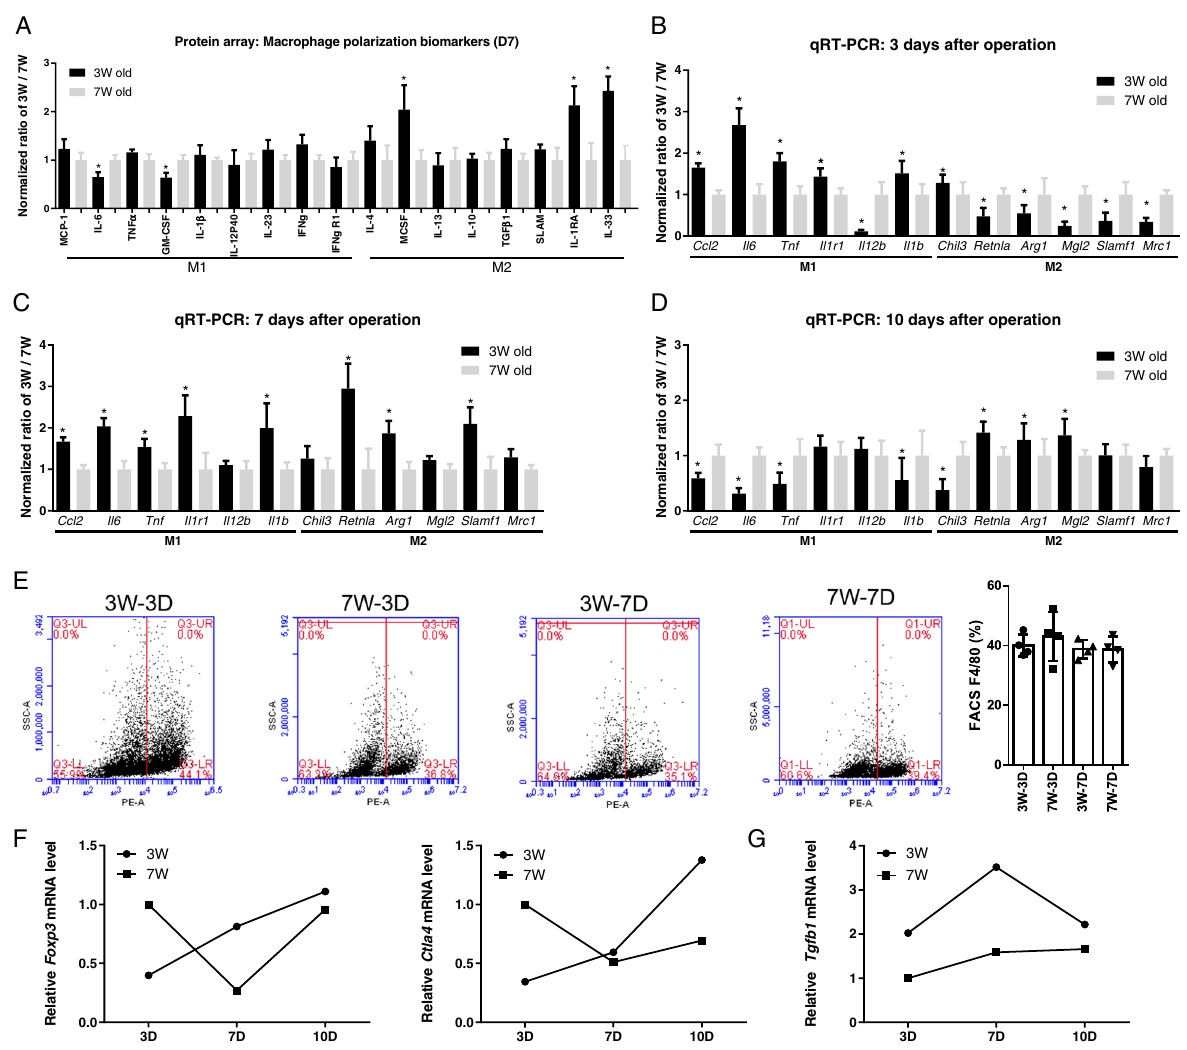
Fig. 3 Immune cells phenotype in wound healing. A At day 7, 3W mice have less M1 and more M2 protein biomarkers. B At day 3, 3W mice have more M1 and less M2 mRNA levels ( n 6–8). C At day 7, 3W mice have more M1 and M2 mRNA levels ( n 6–8). D At day 10, 3W mice have less M1 = = and more M2 mRNA levels ( n 6–8). E At third day (D3) and seventh day (D7), there is no difference in macrophage infiltration between 3 and 7W = mice. (3W-3D, 40.00 1.864; 7W-3D, 43.00 4.106; 3W-7D, 38.78 1.511; 7W-7D, 38.61 2.170; n 4.) F Foxp3 and Ctla4 mRNA levels at 3D, 7D, and ± ± ± ± = 10D, respectively. ( n 3) G 3W mice have higher Tgfb1 mRNA expression levels ( n 3). * P < = =